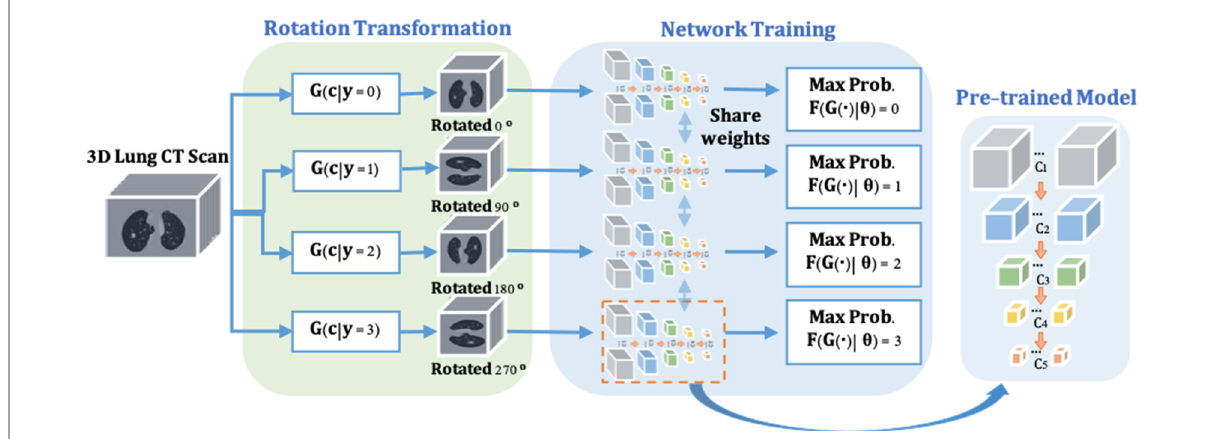
FIGURE 2 The pre-trained model training consists of two steps. (1) Rotate on input 3D CT scans with four angles as 0 (cid:3) , 90 (cid:3) , 180 (cid:3) , 270 (cid:3) by the rotation transformation network. (2) The rotation prediction pretext tasks uses the backbone network ( ResNet-18 ) of the proposed nodule detector ( 3DFPN ) for feature extraction and 2 fully connected (FC) layers to obtain the maximum rotation prediction